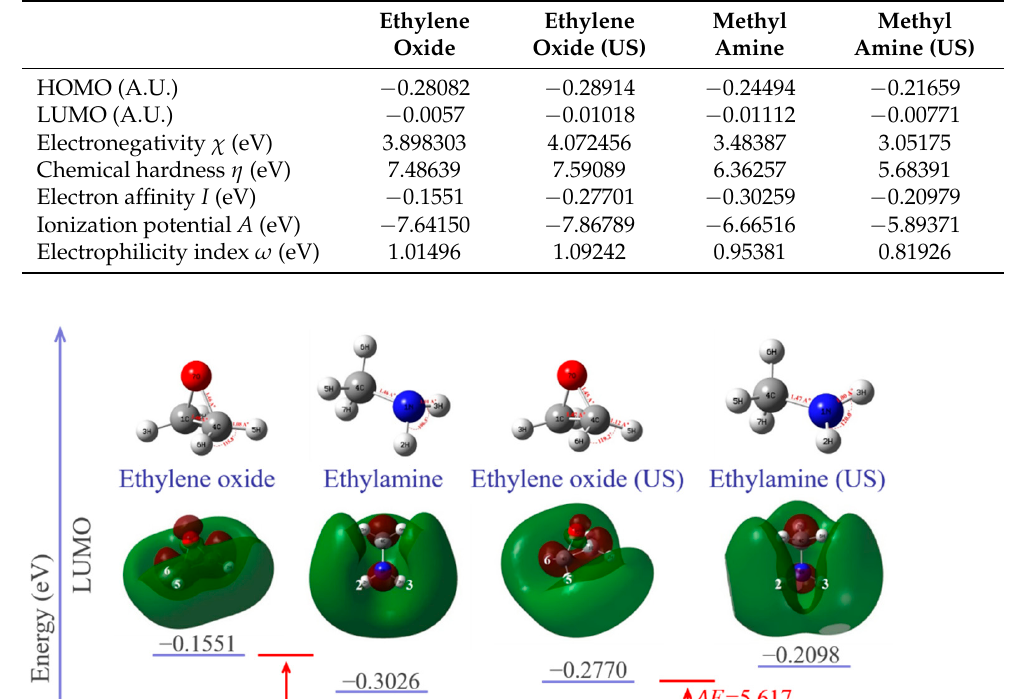
Table 5. Global reactivity indices, calculated at the B3LYP/6-311G (d,p) level.